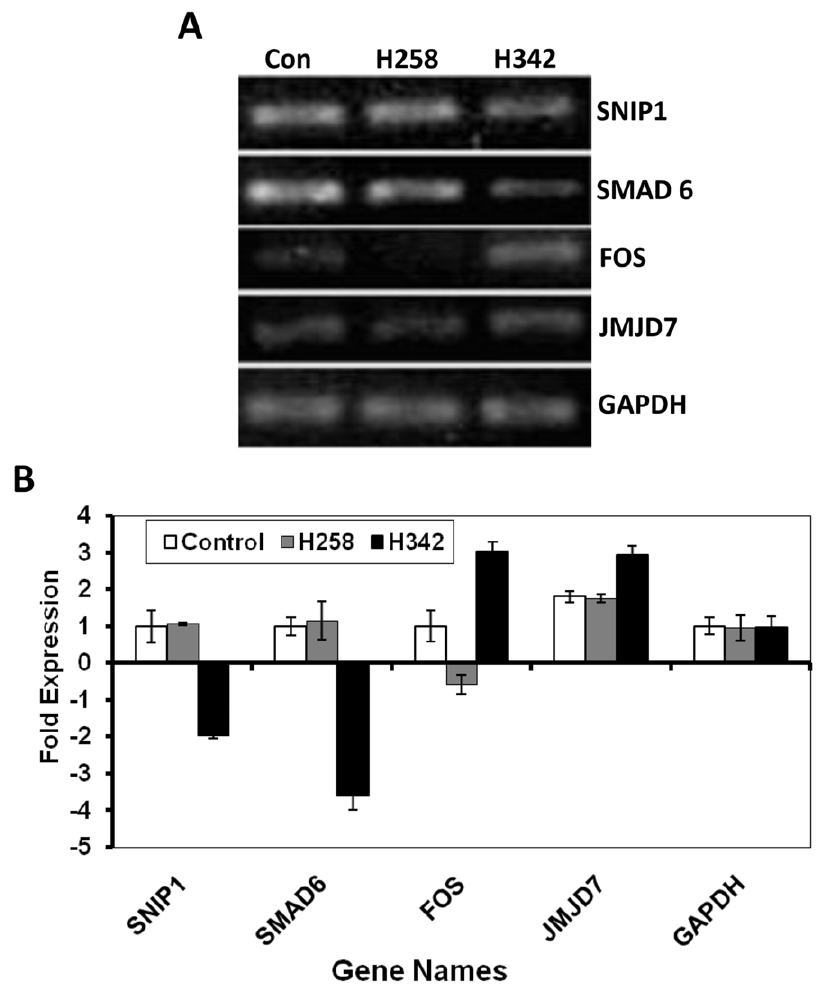
Figure 6. Real-time RT-PCR for microarray data validation. A, Four gene products of the real-time RT-PCR were visualized after separation on an agarose gel. B, Comparing differences of PCR cycles of four genes.